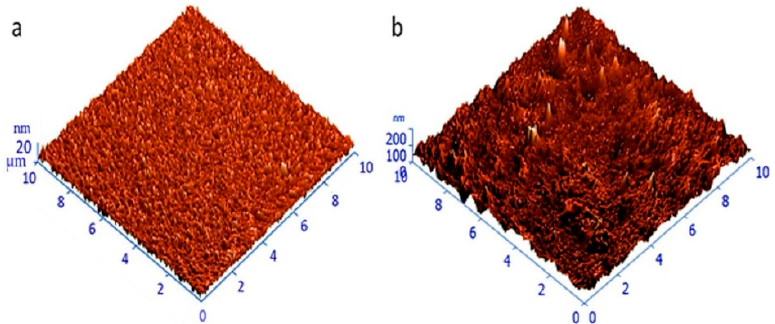
Figure 6. AFM images of neat Ge ( a ) and the corresponding nanocomposite with 1.57% ZnO (Zn/Ge) ( b ). Reprinted from [47], copyright 2019, with permission from Springer Nature.